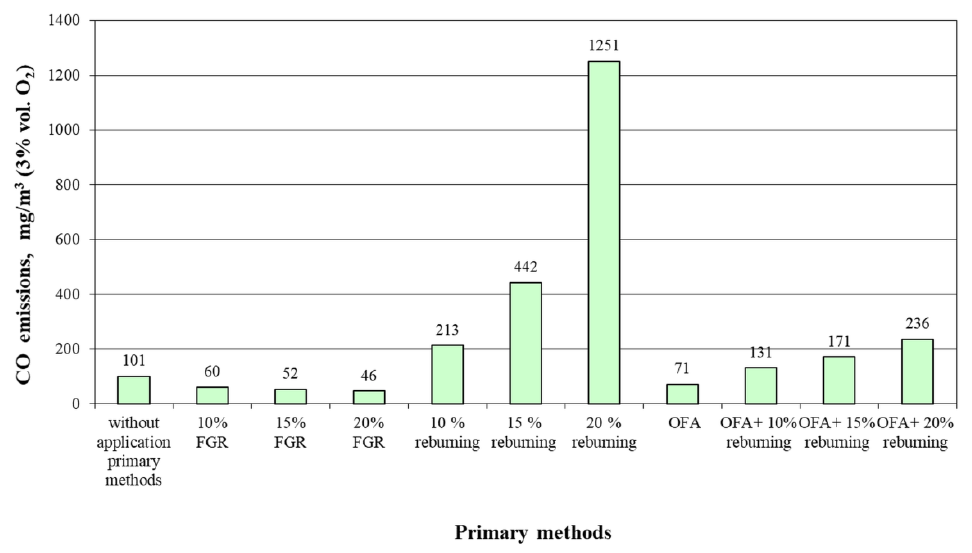
Figure 4. CO content in flue gas is a result of application of individual de-NO x methods and their combinations at total fuel input Q = 1.5 m 3 / h and air excess coe ffi cient m = 1.1.